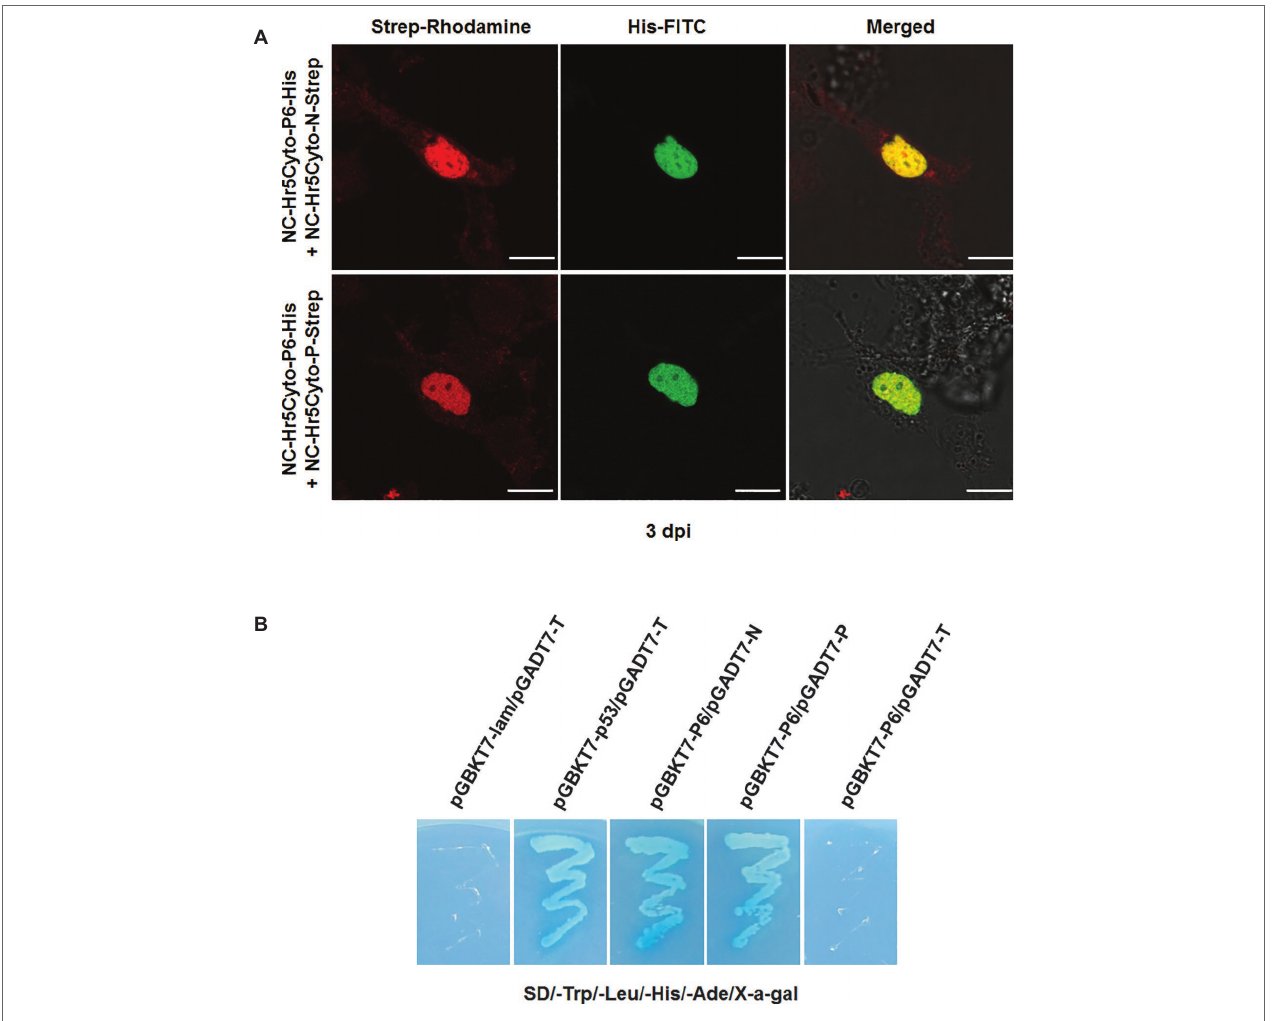
FIGURE 5 | Colocalization and interactions of RYSV P6 with N and P in vivo and in vitro . (A) P6-His/N-Strep and P6-His/P-Strep were coexpressed in the N. cincticeps cell using the corresponding plasmids, while the Dicer2 gene was knocked down by dsRNA treatment. The VCM samples were fixed and inoculated with antibodies to the His and Strep tags. Scale bar: 20 μm. (B) Yeast two-hybrid assay for the interactions of P6 with N and P6 with P. The transformed cells were grown on SD/-Trp/-Leu/-His/-Ade solid medium supplemented with 40 μg/ml X- α -Gal. pGBKT7-53 and pGADT7-T were used as the positive control. Yeast cells co-transformed with pGBKT7-Lam/pGADT7-T, pGBKT7-N/pGADT7, and pGBKT7/pGADT7-P were used as negative